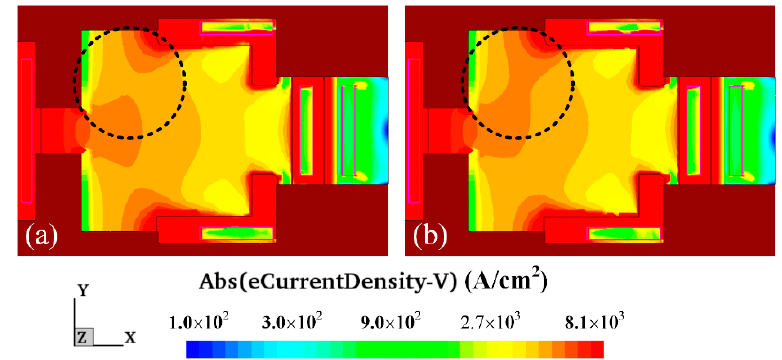
Figure 5. Carrier density distribution of the MMF sensor under the z ‐ direction magnetic field.